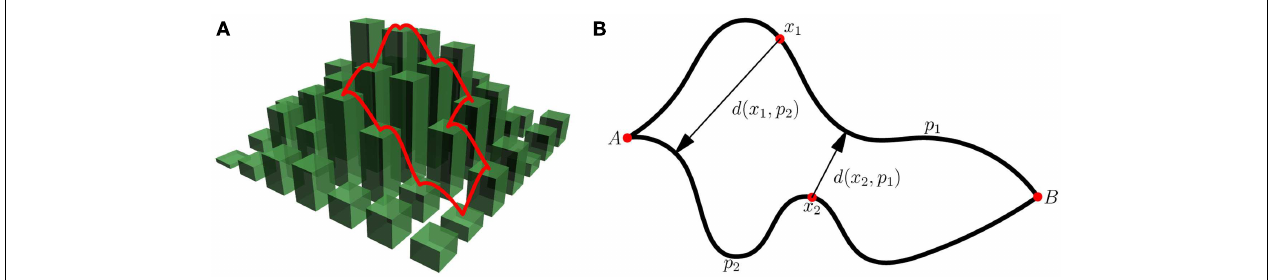
the product of their probabilities of occurrence and the inter-path distance. (B) Illustrates the calculation of the inter-path distance d ( p 1 , p 2 ). For every point x 1 ∈ p 1 we find the closest point on p 2 and record the distance d ( x 1 , p 2 ).We perform the same operation for points on p 2 .The distance is then d ( p 1 , p 2 ) = ( (cid:80) p 1 d ( x 1 , p 2 ) + (cid:80) p 2 d ( x 2 , p 1 ))/(length( p 1 ) + length( p 2